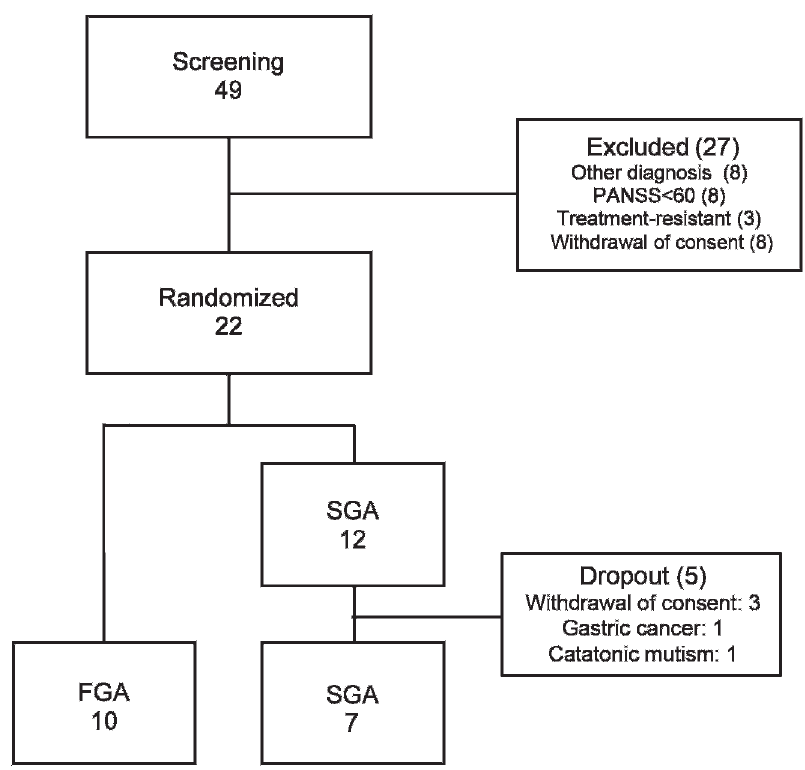
Figure 1 - A patient allocation flow diagram. FGA: First-generation antipsychotic; SGA: second-generation